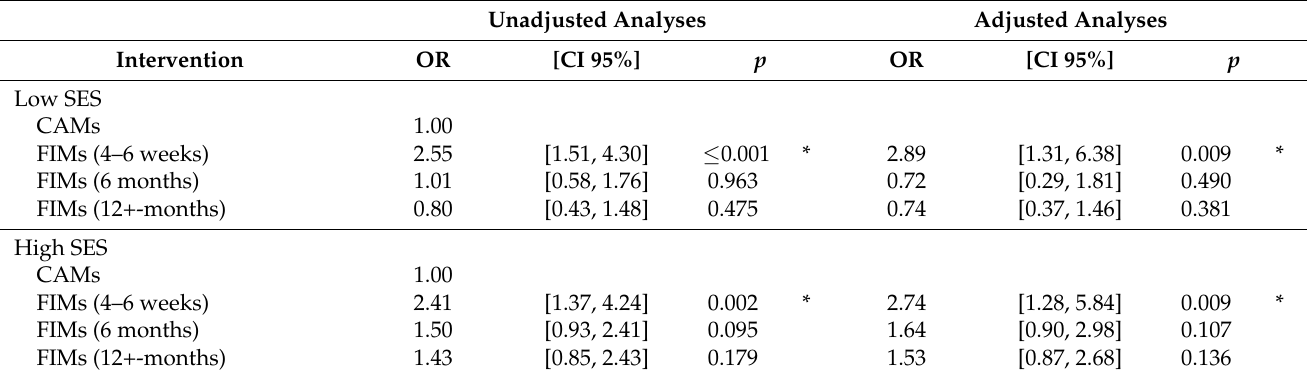
Table A1. Unadjusted and adjusted logistic regression analysis of the effect (successful quitting) in the financial incentives municipalities (FIMs) compared with the campaign municipalities (CAMs) at the end of the intervention, and after 6 and 12+-months. The results are based on a complete case approach and stratified by socioeconomic status (SES). OR: odds ratio, CI: confidence interval. Unadjusted Analyses Adjusted